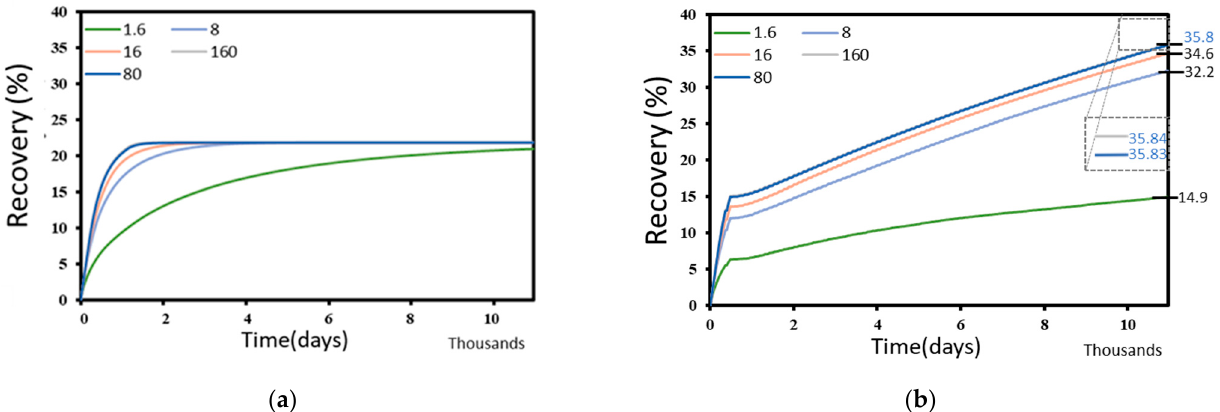
Figure 18. Recovery percentage over time with respect to different fracture conductivity for ( a ) nat- ural depletion and ( b ) HnP scenario. depletion and ( b ) HnP